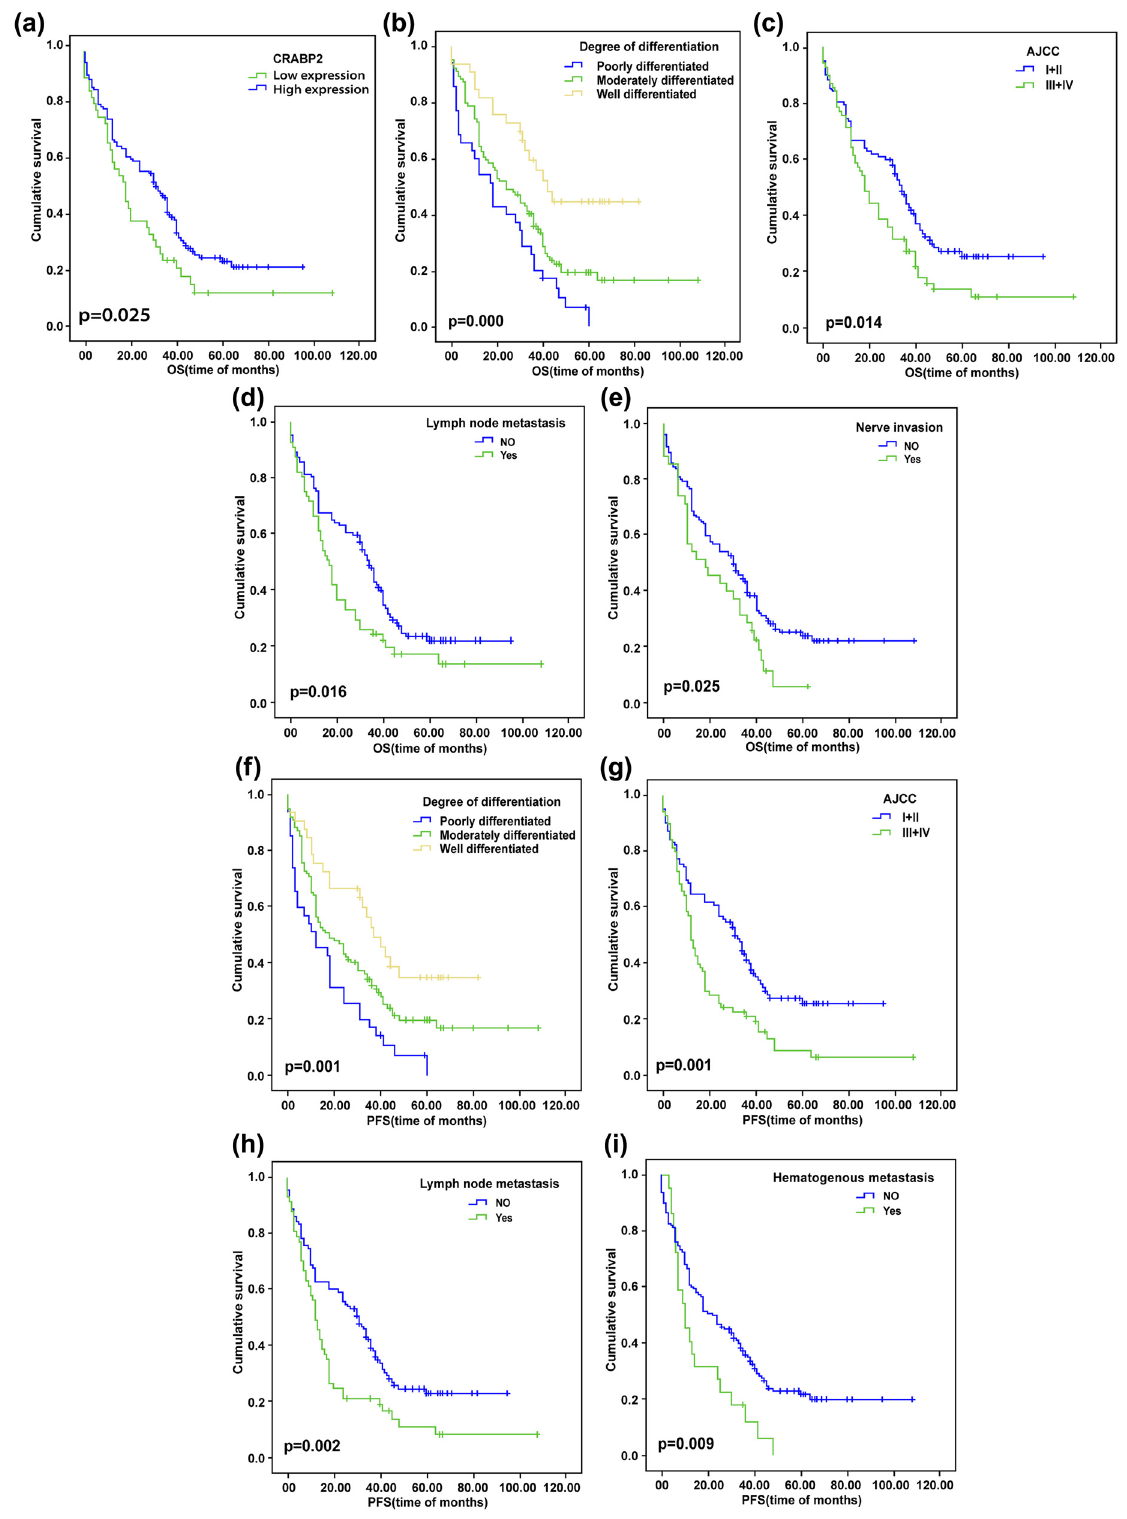
Figure 7: Kaplan – Meier survival curves for patients. ( a ) The overall survival of patients in ESCC with the expression of CRABP2; ( b ) the overall survival of patients in ESCC with a degree of di ff erentiation; ( c ) the overall survival of patients in ESCC with AJCC; ( d ) the overall survival of patients in ESCC with lymph node metastatic; ( e ) the overall survival of patients in ESCC with nerve invasion; ( f ) progression - free survival of patients in ESCC with a degree of di ff erentiation; ( g ) progression - free survival of patients in ESCC with AJCC; ( h ) progression - free survival of patients in ESCC with lymph node metastatic; and ( i ) progression - free survival of patients in ESCC hematogenous